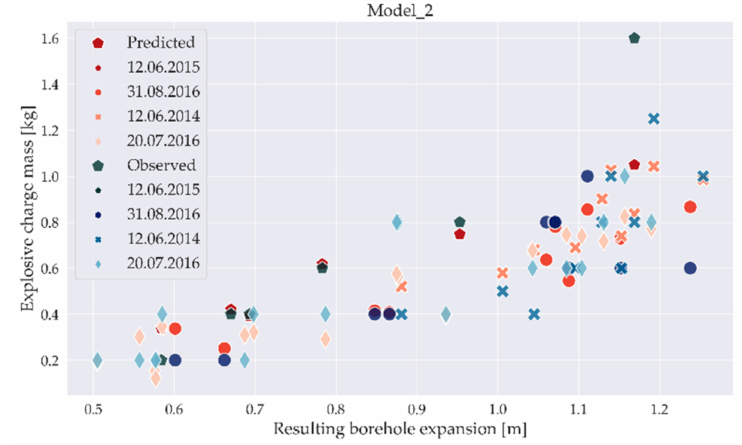
Figure 7. Model_2—Explosive charge mass vs. resulting borehole expansion.